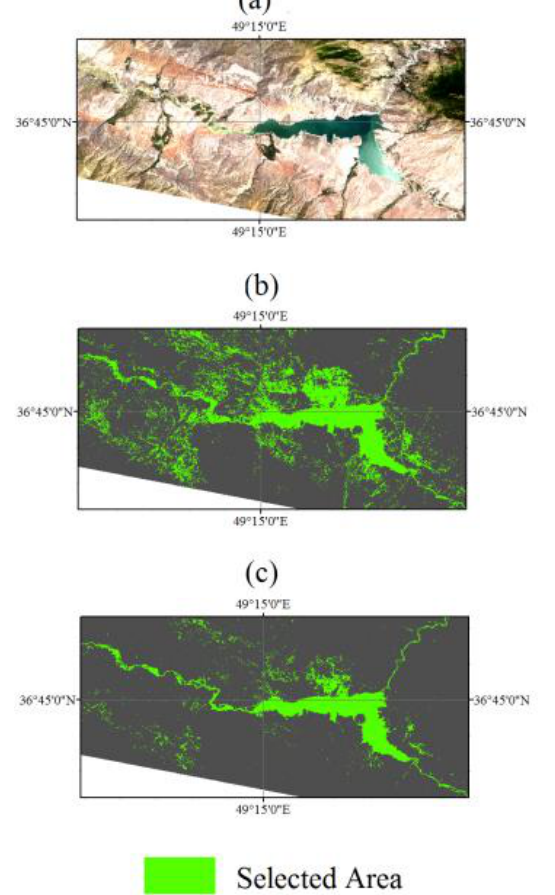
Figure 3. Applying different Δ value for Manjil sluice in the study area. (a) RGB image. (b) Δ=0. 05. (C) Δ= 0.